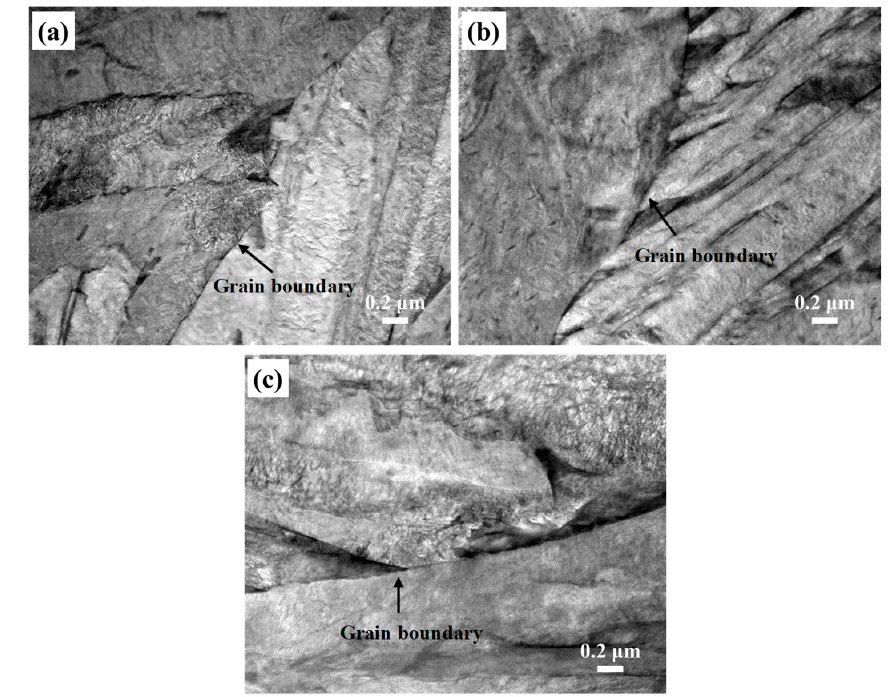
Figure 9. Transmission electron micrographs for the specimens tested at 800 °C: ( a ) unadded steel, ( b ) P ‐ added steel, and ( c ) P+Ce ‐ added.